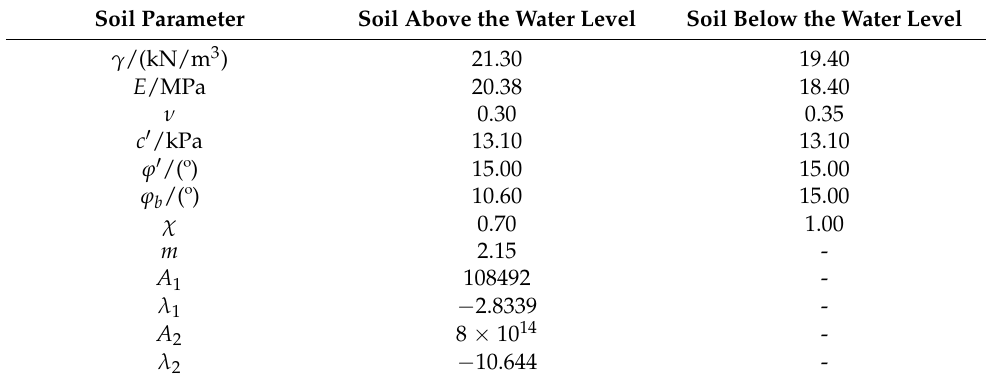
Table 2. Parameters of the soil.